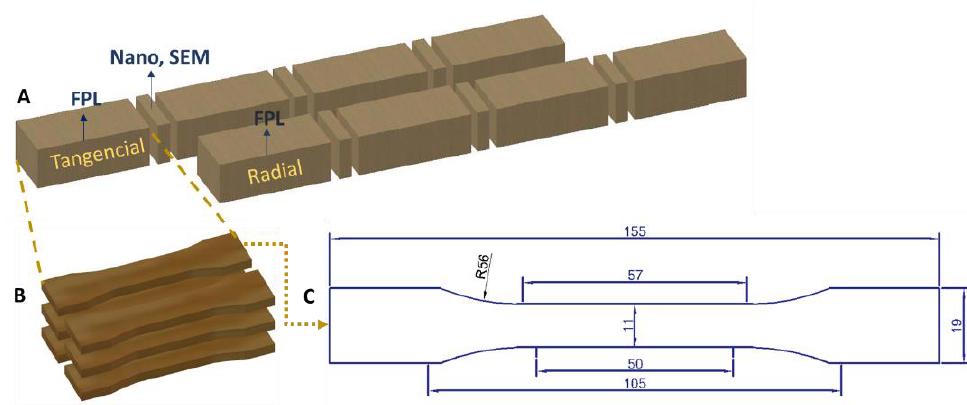
Figure 1. Diagram for obtaining the specimens in a strip: ( A ) sections in a wooden strip: tangential and radial; ( B ) dog bone specimens per section; ( C ) dimensions in millimeters (mm) of the dog bone specimen.